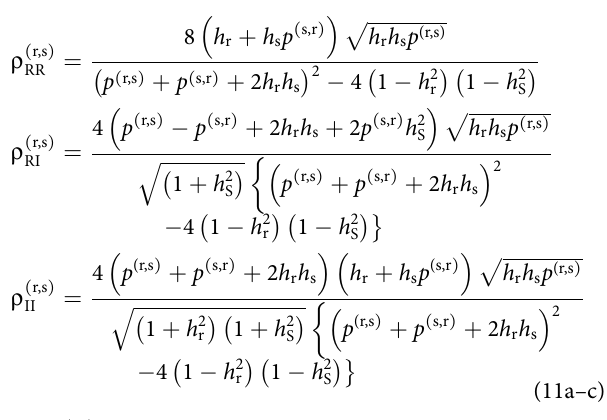
FIGURE 18 | Extracted progress of story-wise distribution of VE material area and varying peak interstory drift angles in 20-story building . (A) Iterative design process of story-wise distribution of VE material area. (B) Variation in peak interstory drift angles for the upper distribution of VE